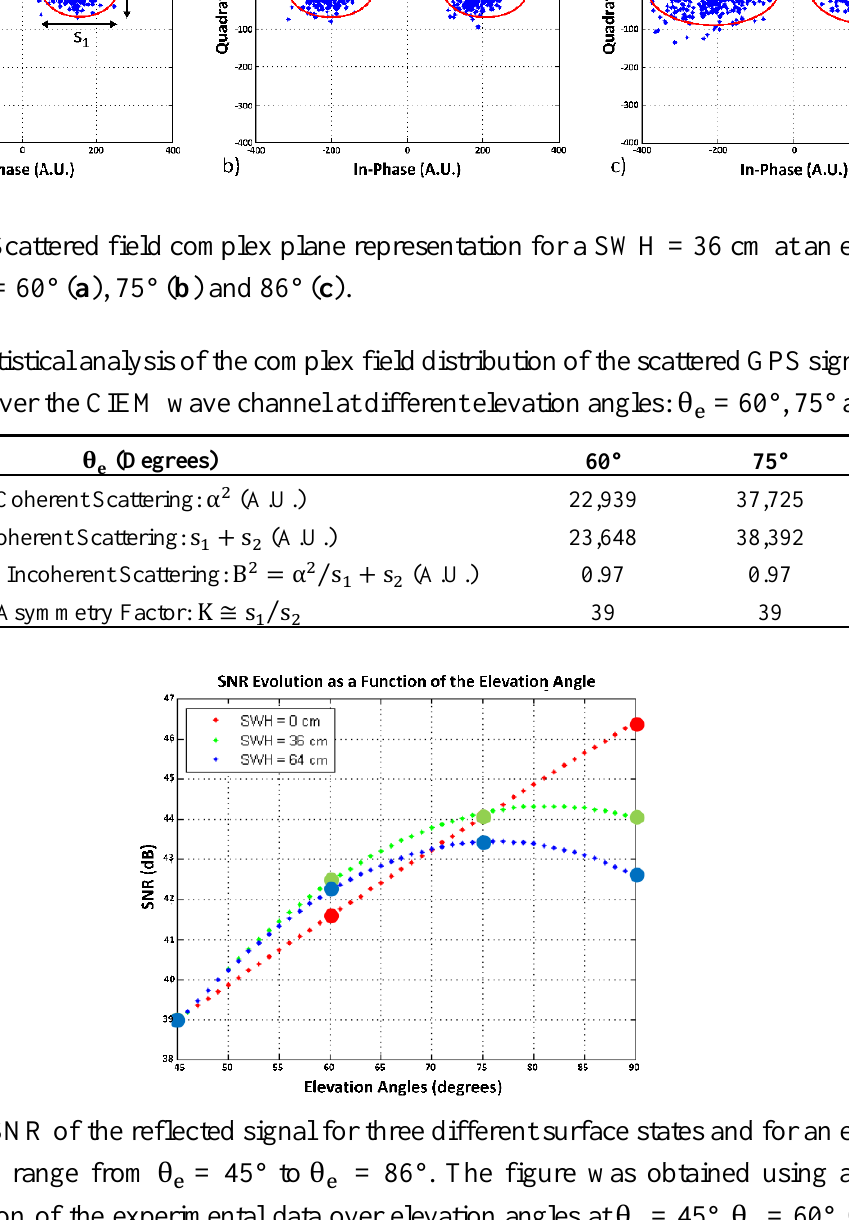
= 45°, θ = 60°, θ = 75° e e e